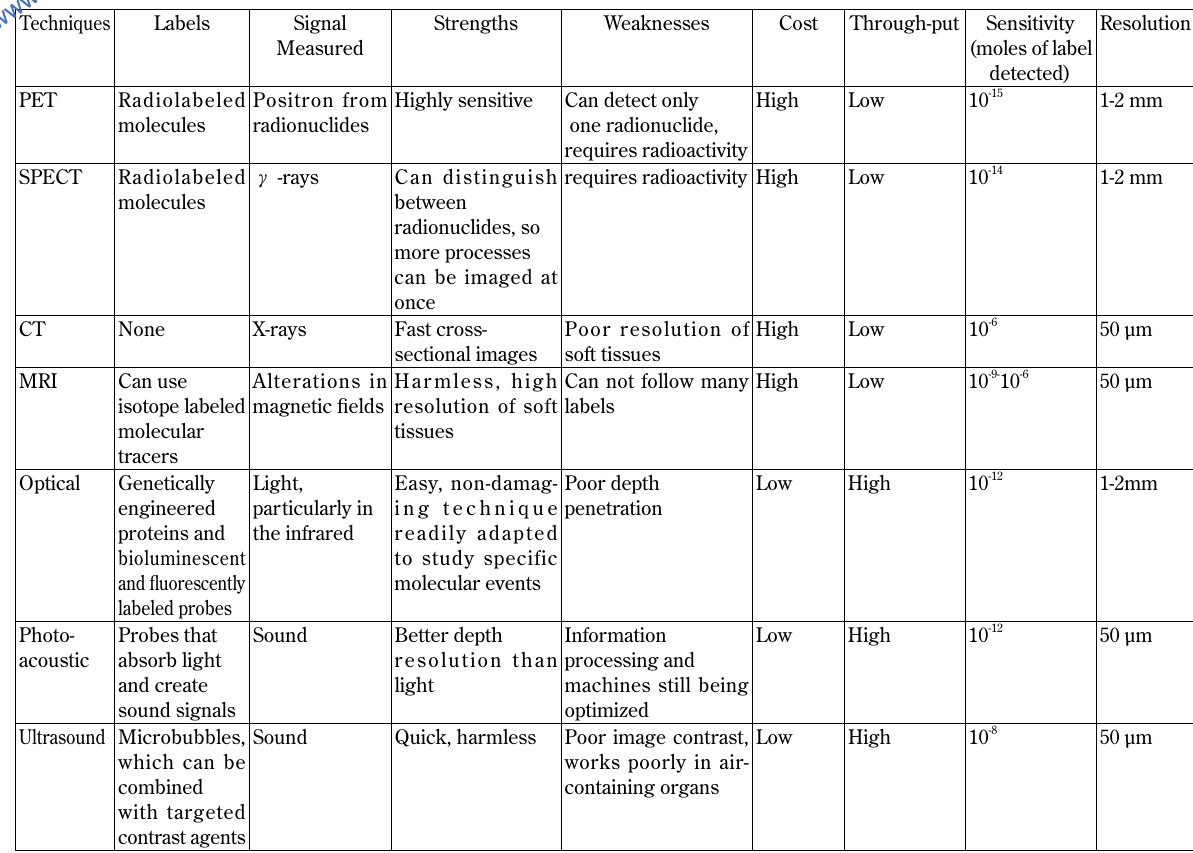
Table 1 Comparison of commonly used imaging modalities for small animal imaging (Reprinted, with permission, from Reference